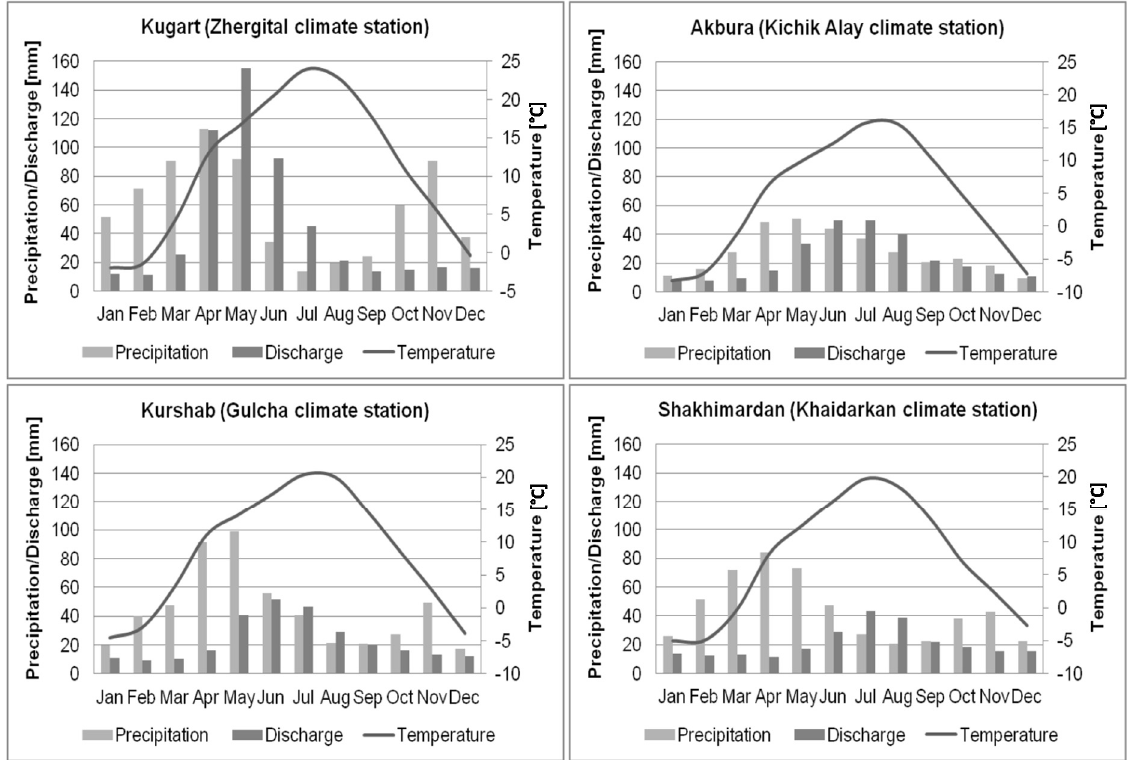
Figure 4. Hydrometeorological regime for the four studied catchments for the